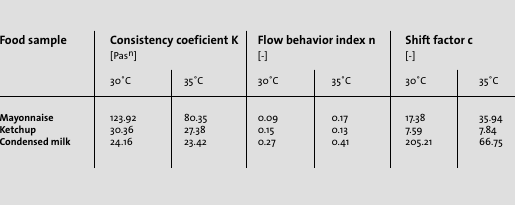
Table 2 (left): K and n values of the power law model and shift factors used to estab- lish the modified Cox-Merz relationship for selected foods tested at 30˚C and 35˚C. Table 3 (right): Consistency and power indexes for cream cheese at 30˚C and